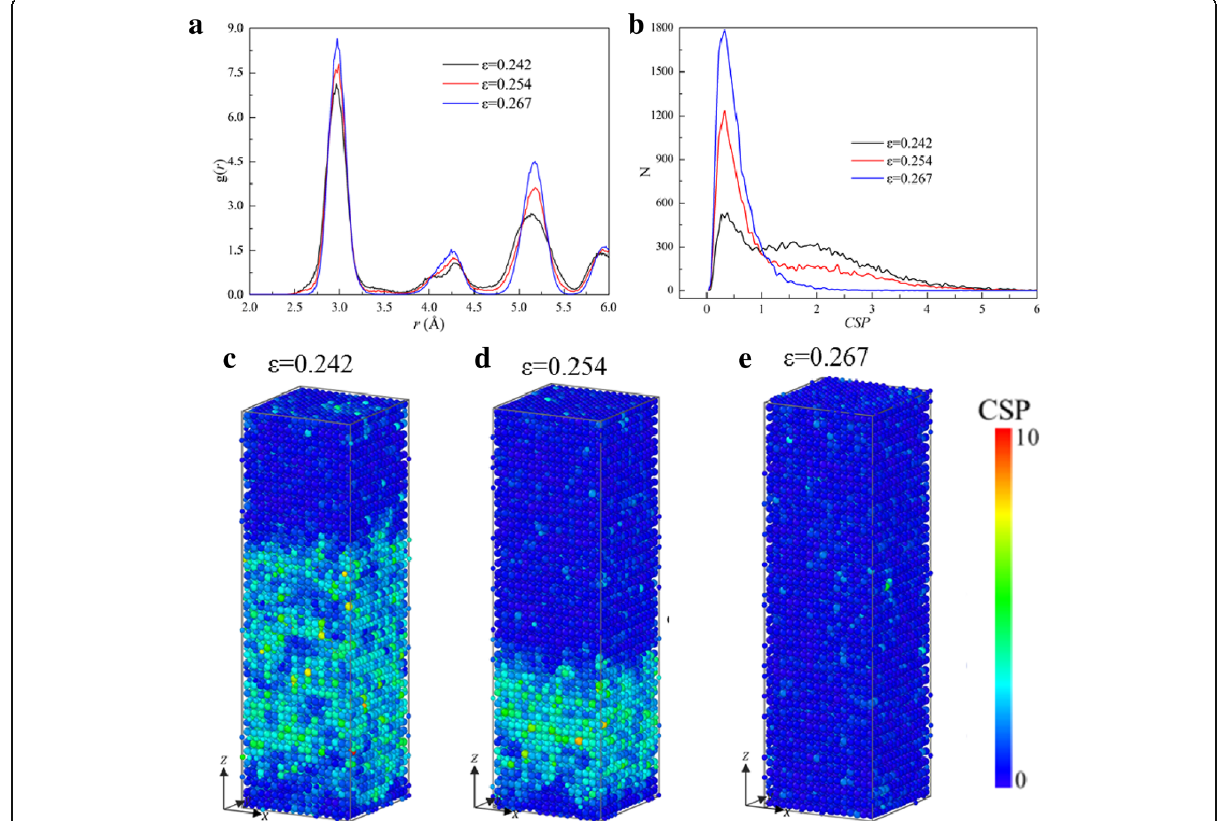
Fig. 6 a RDF , b N - CSP plots of sample under tension along [001]. c – e Distribution of CSP in sample at different